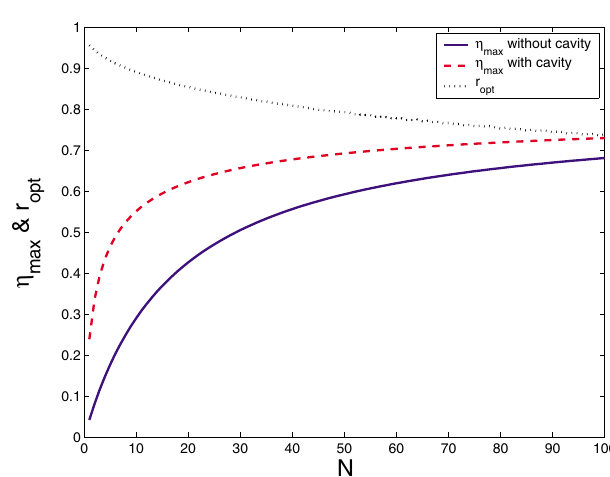
FIG. 5. (Color) The maximum efficiencies and optimum reflec- tivity versus number of bunches for (cid:21) (cid:1) 0 : 05 . The average unloaded gradient is 160 MV = m